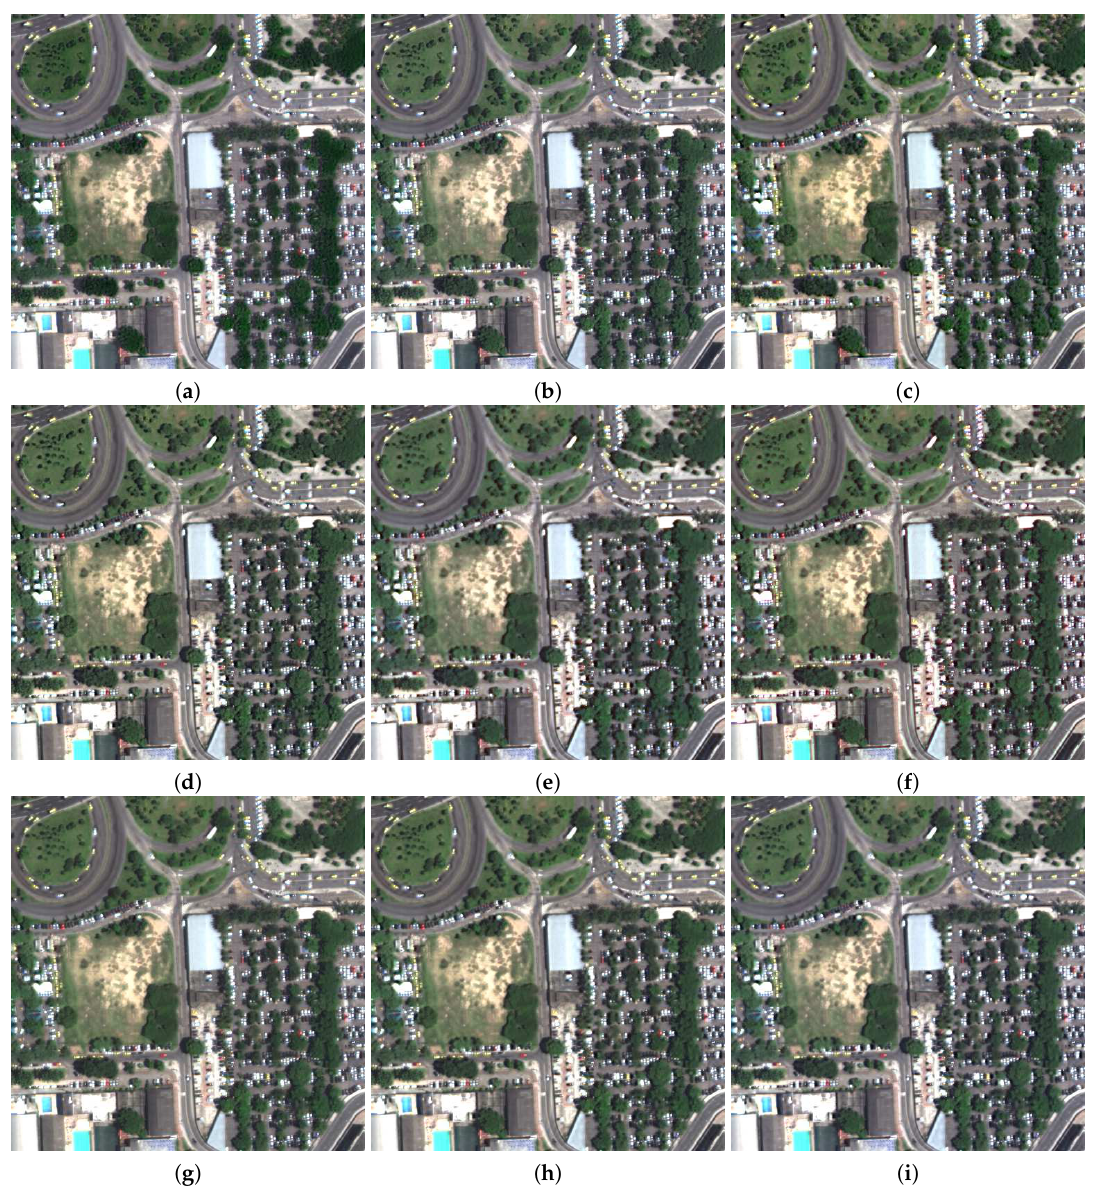
Figure 9. True-color compositions of 512 × 512 details of 0.5 m full-scale pansharpened WorldView-2 Rio for the following methods: ( a ): GS; ( b ): GSA; ( c ): BDSD; ( d ): MTF-GLP-CBD; ( e ): AWLP-Otazu; ( f ): AWLP-Toolbox; ( g ): OBT-H; ( h ): MTF-GLP-HPM-H; ( i ):